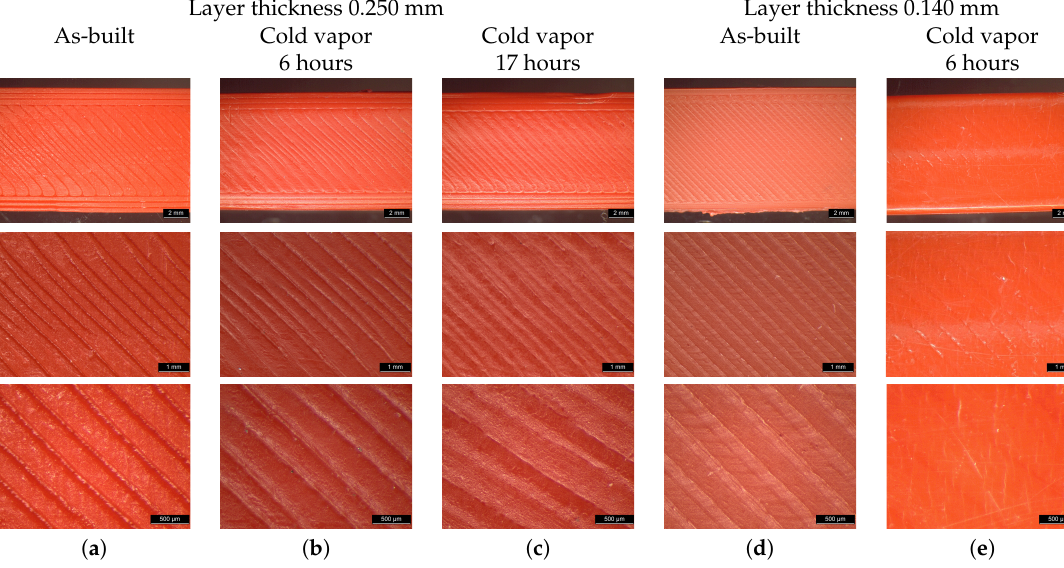
Figure 3. Optical microscope images of external surface of acrylonitrile butadiene styrene (ABS) printed tensile test samples for different acetone-based after-treatment processes and layer